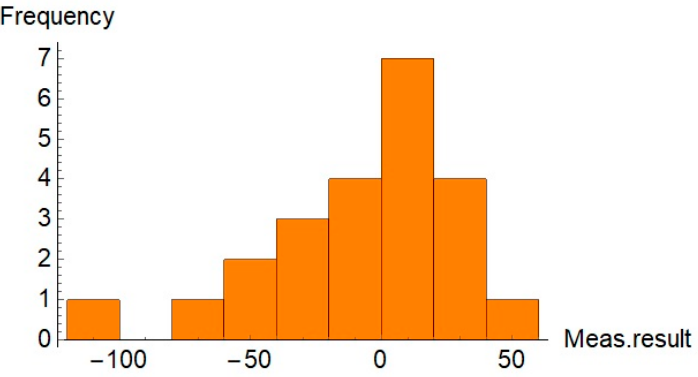
Figure 9. Histogram of the relative difference between compared results for the second set of the parts.